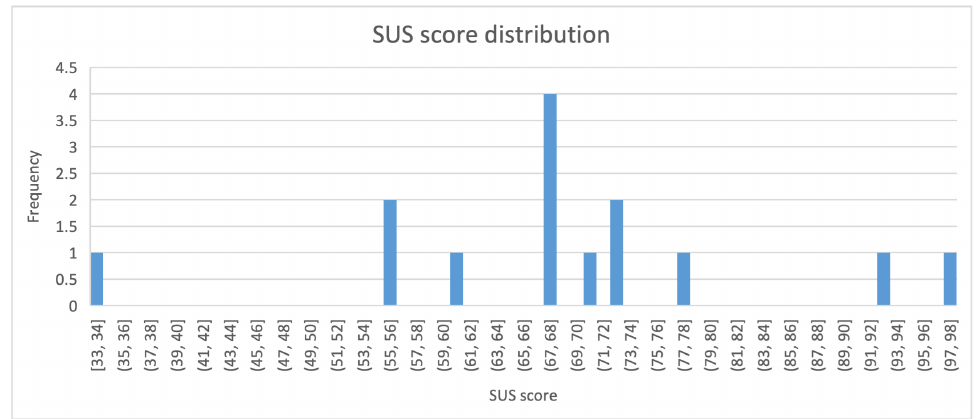
Figure 19. SUS scores of the interface developed for the exploratory analysis of heterogeneous data use case. The X-axis indicates a certain range of the score. The Y-axis indicates the number of participants who gave the score within the